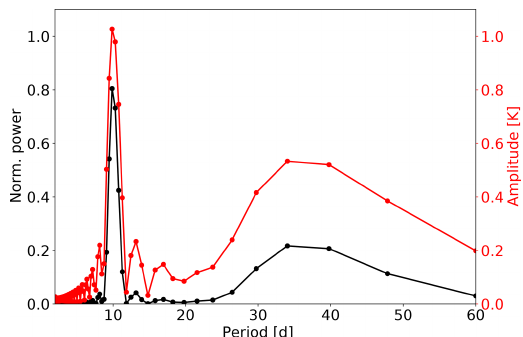
Figure 1. Example LSP for a time series composed of two sinu- soids. The first one has a period of 10d and an amplitude of 1K and the second has a period of 35d and an amplitude of 0.5K. The normalised power is shown as a black curve and the amplitude as a red curve with a second axis to the